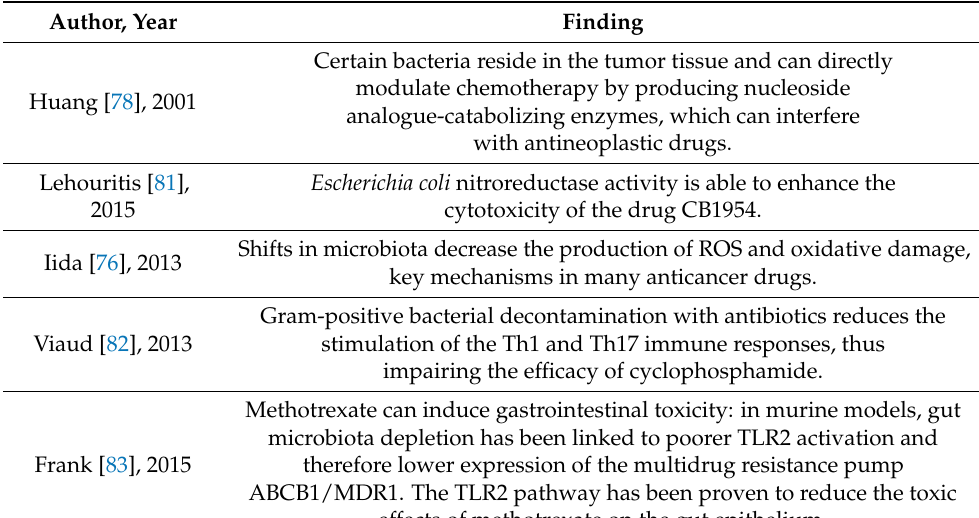
Table 2. Main studies on the gut microbiota and chemotherapy